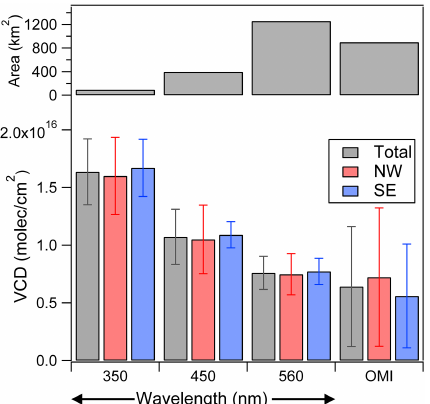
Figure 11. Comparison between the NO 2 VCD obtained at the three wavelengths with the NO 2 VCD measured by OMI, for two OMI pixels located to the NW and SE of the site during the OMI over- pass on 17 June 2013. The area probed by the azimuth scan at each wavelength and the OMI pixels is represented on